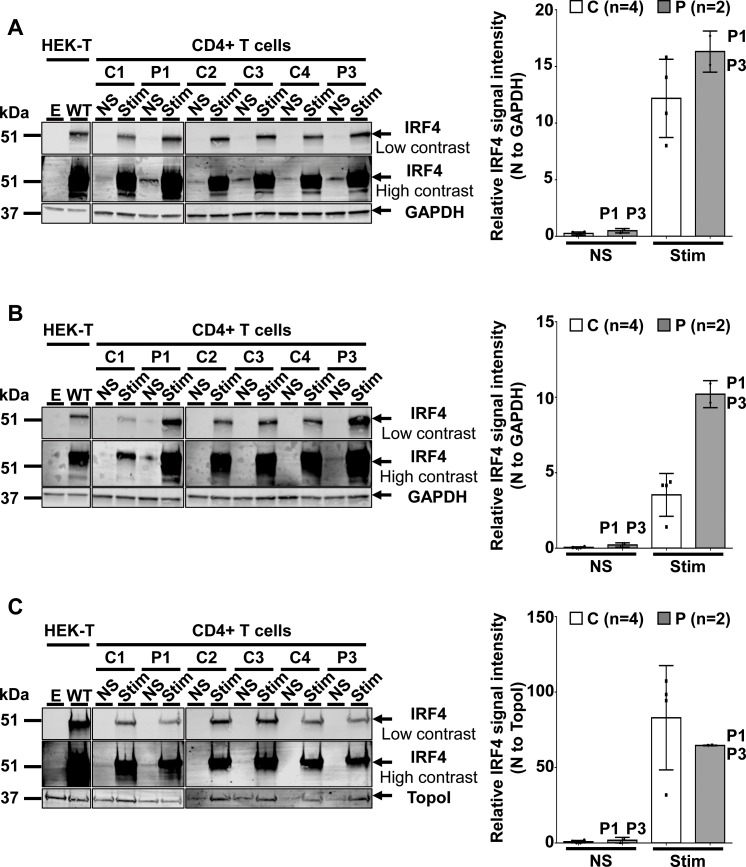
IRF4 protein levels in CD4+ T cells.(A–C) (Left) Total-cell (A), cytoplasmic (B) and nuclear (C) extracts from CD4+ T cells from four healthy unrelated controls (C1 to C4) and two patients (P1 and P3) stimulated with activating anti-CD2/CD3/CD28 monoclonal antibody-coated beads (Stim) or left unstimulated (NS). Protein extracts from HEK293T cells transfected with the pcDNA3.1 empty vector (E) or plasmids encoding IRF4 WT plasmids were used as controls for the specific band corresponding to IRF4. (Right) Representation of IRF4 signal intensity for each individual, obtained by western blotting, with normalization against the GAPDH signal (total, cytoplasmic extracts) or the topoisomerase I signal (nuclear extracts).10.7554/eLife.32340.029Figure 5—source data 1.Immunophenotyping of patients (P1, P2 and P3) and a WT homozygous relative. All subjects had normal numbers and percentages of T, B, and NK cells for age.